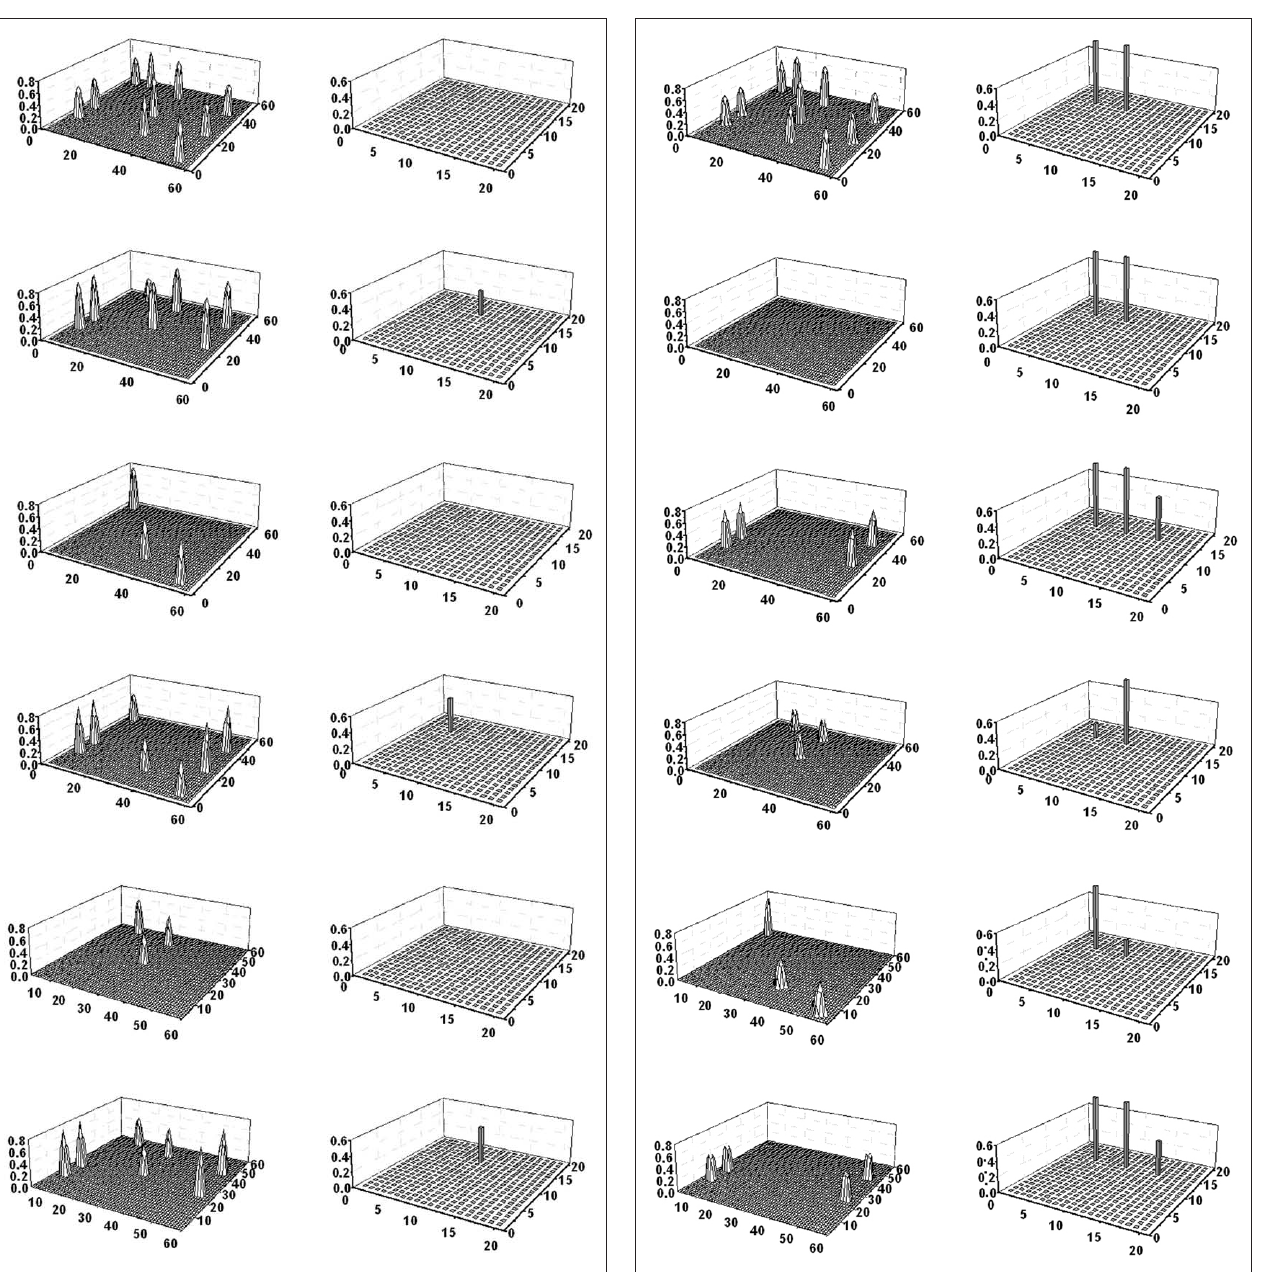
Figure 7 | Simulation of a word recognition task in which the subject must recognize two words from the same category. The two words naming “dog” and “cat” are given to the semantic network. The six lines represent activity in the semantic network (left panels) and in the lexical network (right panels) at steps 12, 32, 60, 81, 100, and 120 of the simulation (duration of each step: 0.2 ms). As the figure shows, the two words initially evoke the four shared properties in the semantic network and consequently the word denoting the category (“pet”) is activated in the lexical area (third line). Hence, the network can generalize from the two members of the category to the category name. The three distinctive features of the two objects oscillate in time division (fourth and fifth lines) causing the momentarily inhibition of the alternative word. Hence, the three words (two members and their category) oscillate in time division in the gamma